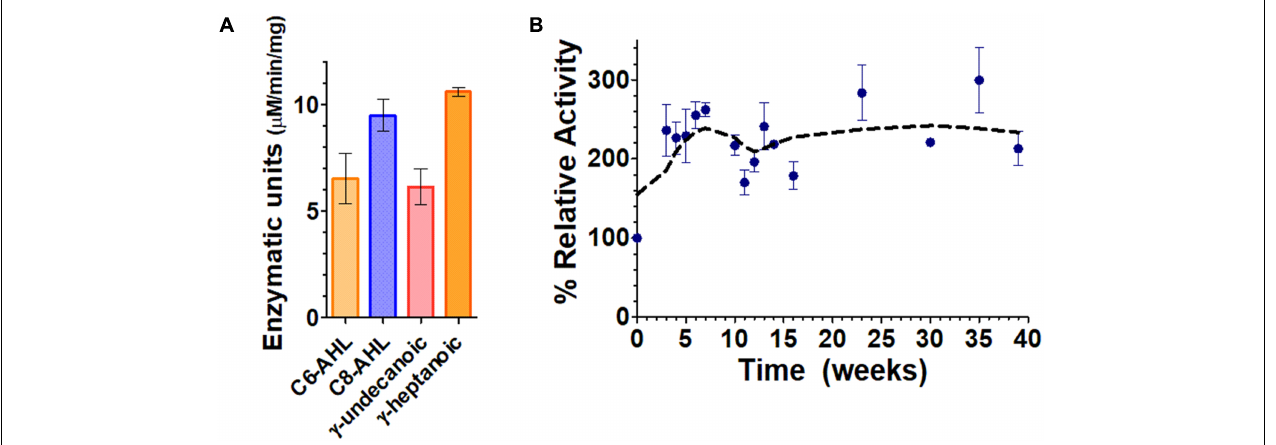
FIGURE 2 | Functionalized silica gel enzymatic activities and durability. (A) Lactone hydrolysis activity of the engineered silica gels containing the lactonase Sso Pox W263I using lactones with short aliphatic chains, i.e., γ -heptanoic lactone ( γ -heptanolactone) and C6-AHL, as well as with lactones with longer aliphatic chains, i.e., C8-AHL and γ -undecanoic lactone as substrates. Lactonase activity is expressed in enzymatic units defined as µ M of substrate hydrolyzed per min per mg of cells. (B) Activity of the enzymatic silica gels over time, using the chromogenic substrate paraoxon as a proxy for enzyme activity.